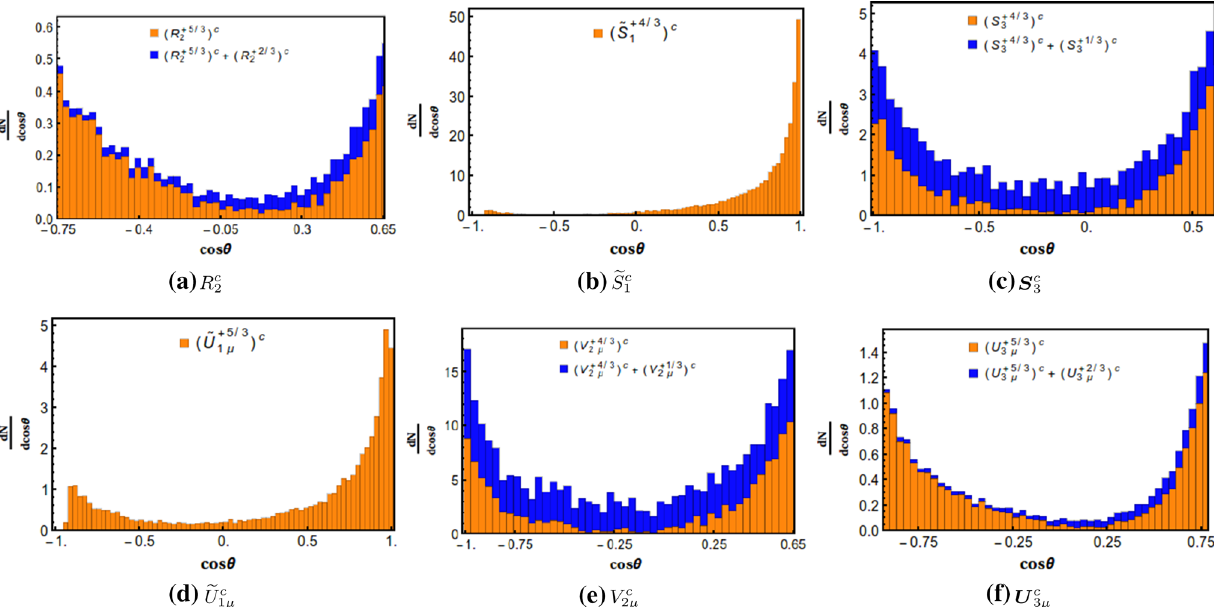
√ s = 3464 . 1 GeV and L int = 2000 fb − 1 . The sub-figure